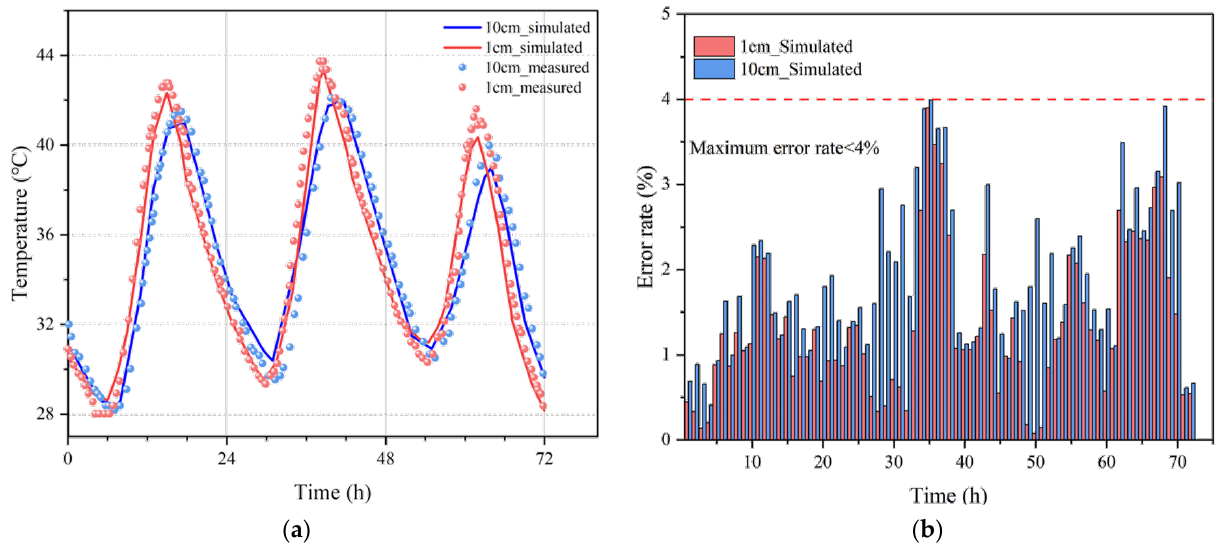
Figure 6. Comparison of measured data and simulated data with error analysis. ( a ) Comparison between the measured and simulated data; ( b ) Error analysis of different depths.